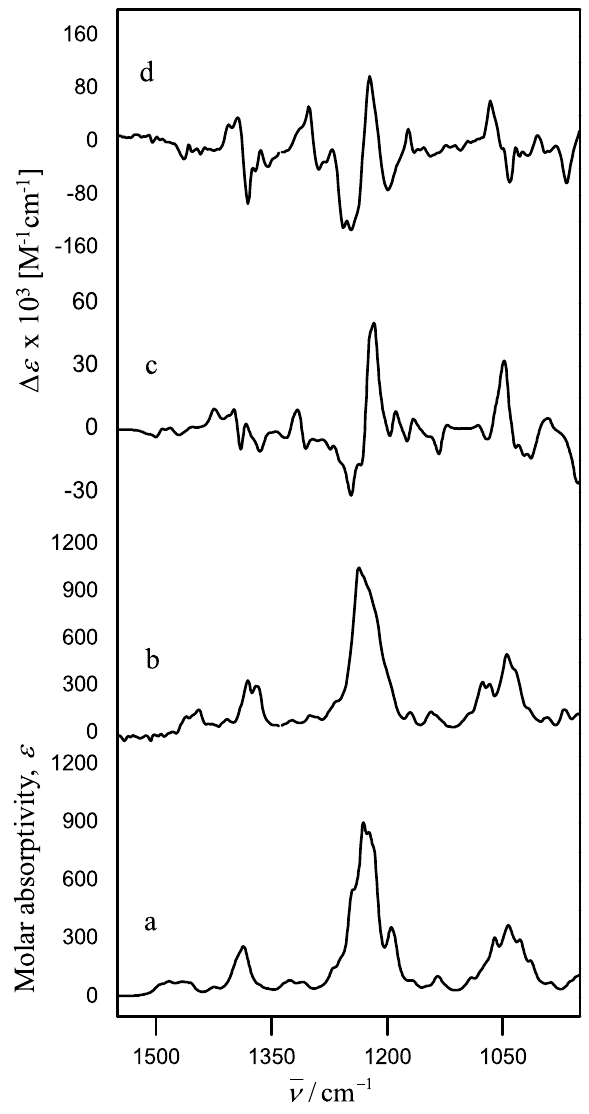
Figure 4. Comparison of the experimental IR ( b ) and VCD ( d ) spectra of briarane B-3 ( 1 ) with the DFT B3LYP/DGDZVP calculated IR ( a ) and VCD ( c ) spectra for (1 S ,2 S ,6 S ,7 R ,8 R ,9 S ,10 S ,11 R ,17 R )-